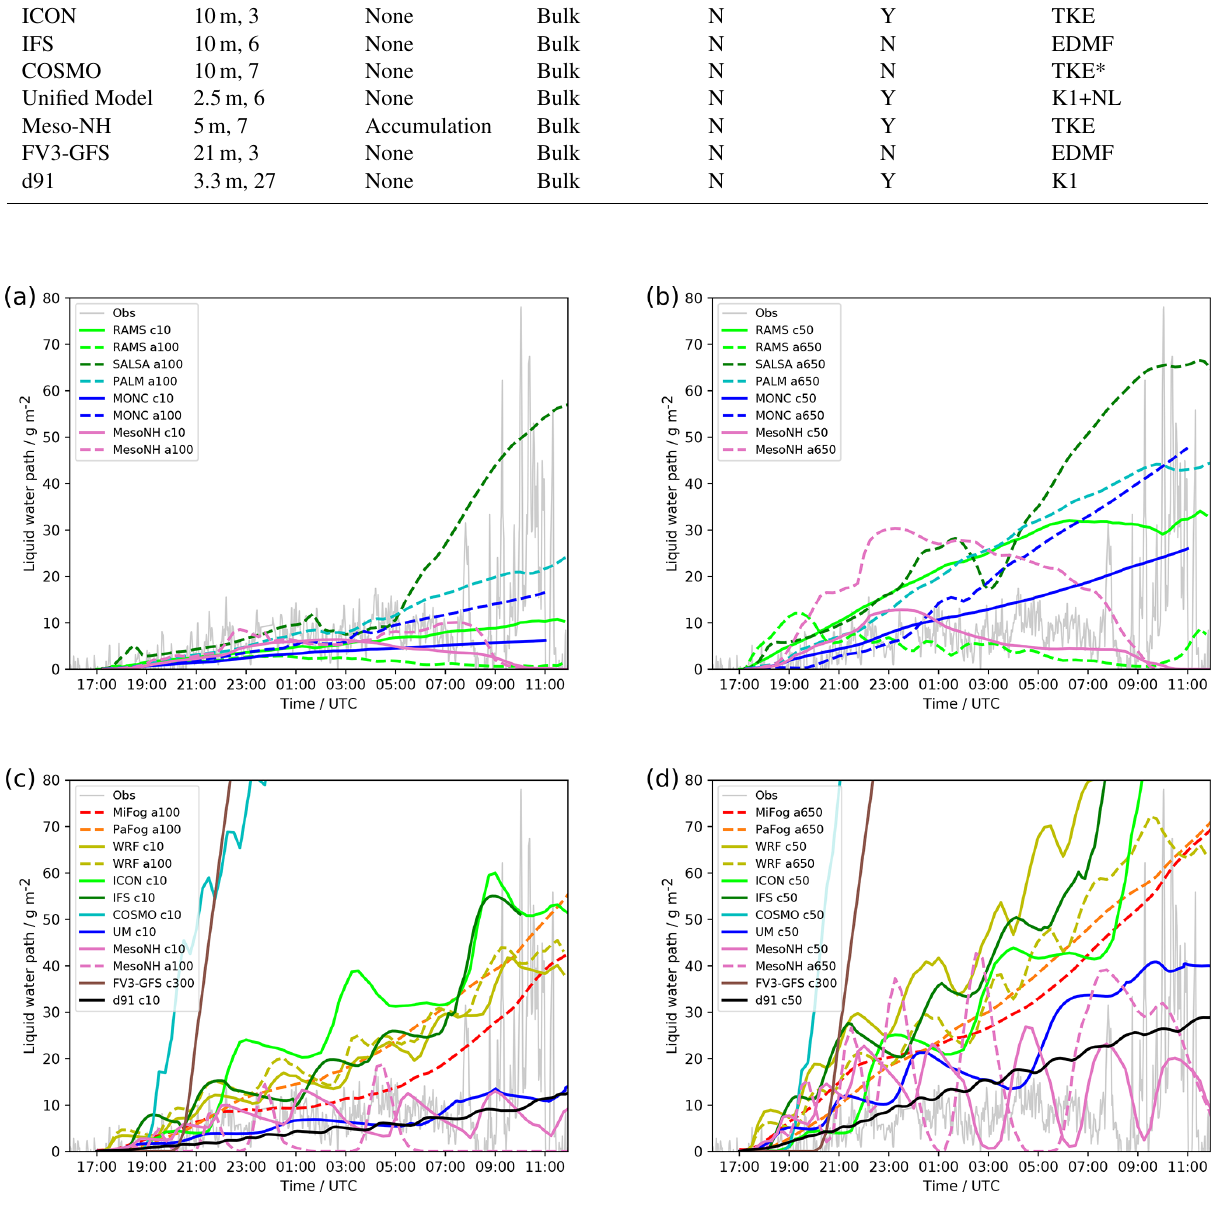
Figure 1. Liquid water path observed and modelled by (a) low aerosol/CDNC LES, (b) high aerosol/CDNC LES, (c) low aerosol/CDNC SCMs, and (d) high aerosol/CDNC